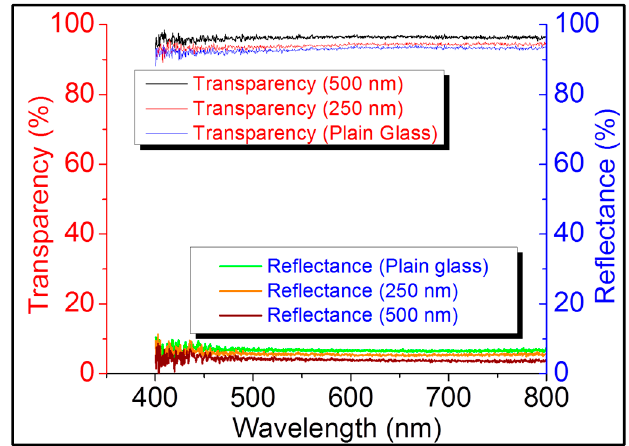
Figure 6. Transparency and reflection measurement in visible light wavelength region (400–800 nm) for plain borosilicate glass, 250-nm-deep, and 500-nm-deep nanostructured borosilicate glass.